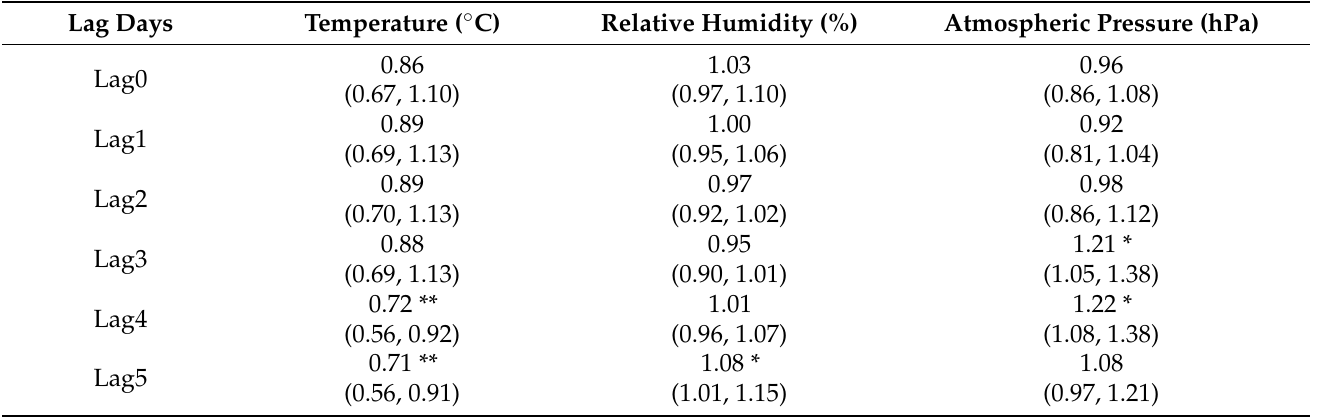
Table 8. Estimated relative risk and 95% confidence interval for overall absence from school due to sickness associated with a 10 ◦ C increase in daily average of temperature, a 10 % in relative humidity, and a 10 hPa in atmospheric